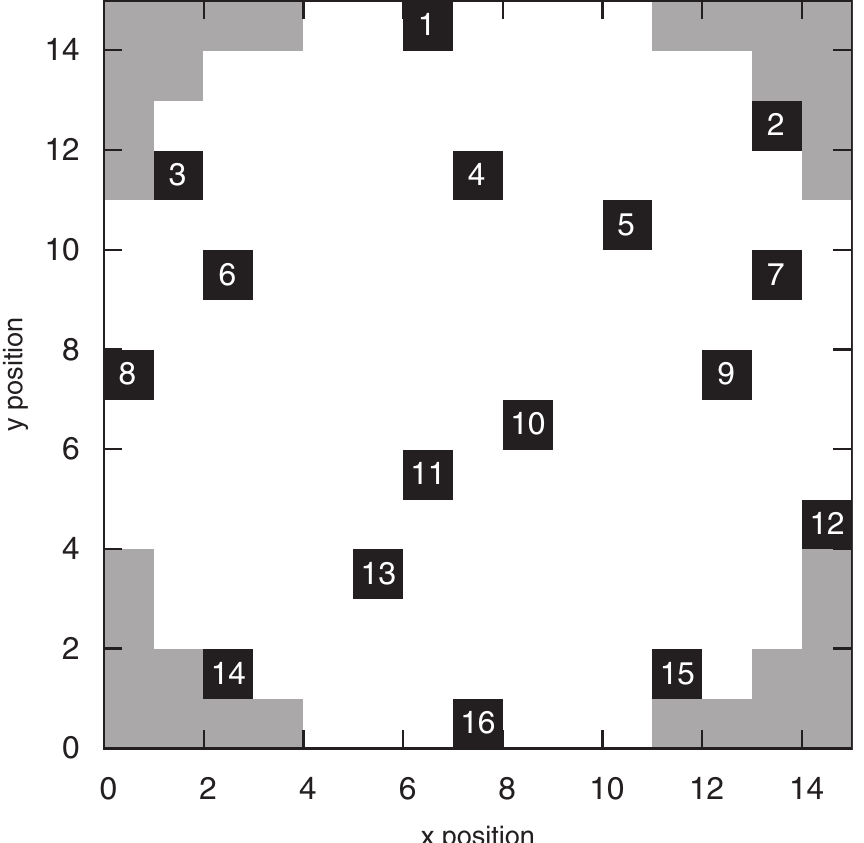
Fig. 3. The idealized Low Granularity MFC (LMFC) instruments within the nuclear core are localised in assemblies in black, in a horizontal slice of the core. The assemblies without instrument are marked in white, and the re fl ector is in